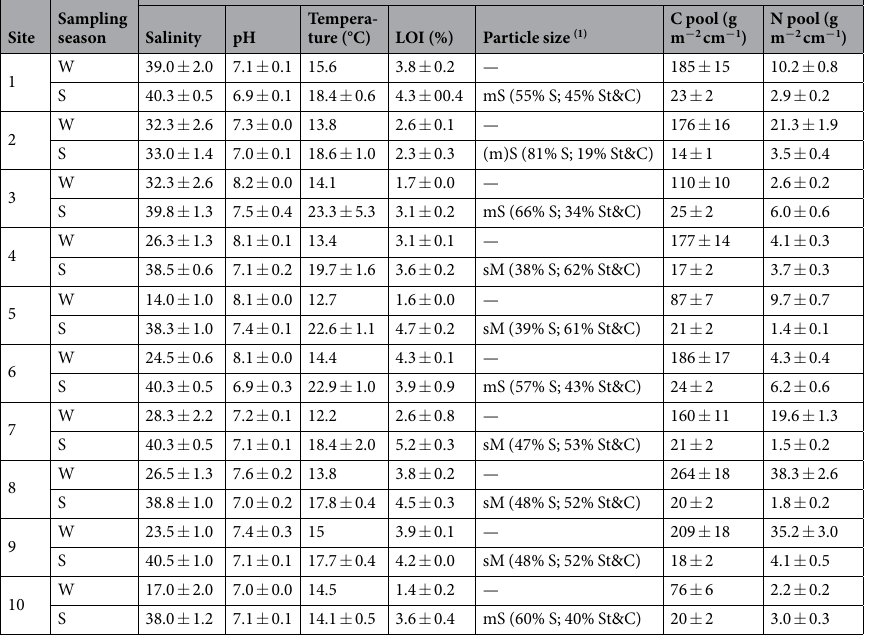
Table 1. Physicochemical characterization of Zostera noltei rhizosediment (0–50 mm depth for interstitial water salinity, pH, LOI, granulometry, C and N pool; mean ± SD), for each sampling site, in winter (W) and late spring (S). (1) According to Blott and Pye (2012) 38 classification (mS: muddy sand (sand > 50% and clay + silt < 50%); (m)S: slightly muddy sand; sM: sandy mud (clay + silt > 50% and sand < 50%)). Relative percentages of sand (S: grain size > 63 μ m) and mud (silt&clay, St&C: grain size < 63 μ m) are shown within brackets for each study